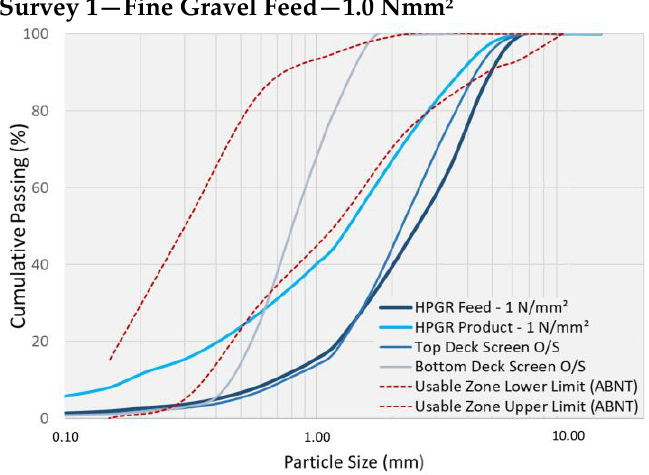
Figure 7. Color scale adopted in the analysis.